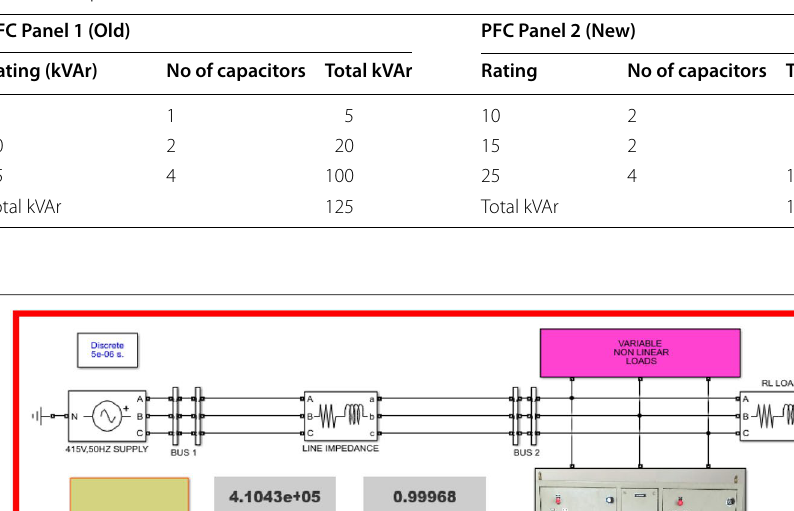
Table 1 Capacitor bank details at SUES Substation